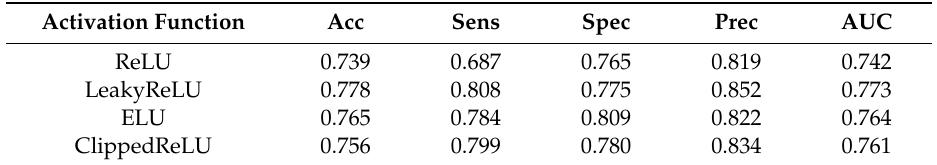
Table 9. Experimental results using IGRNet with various activation functions on the total independent test set.